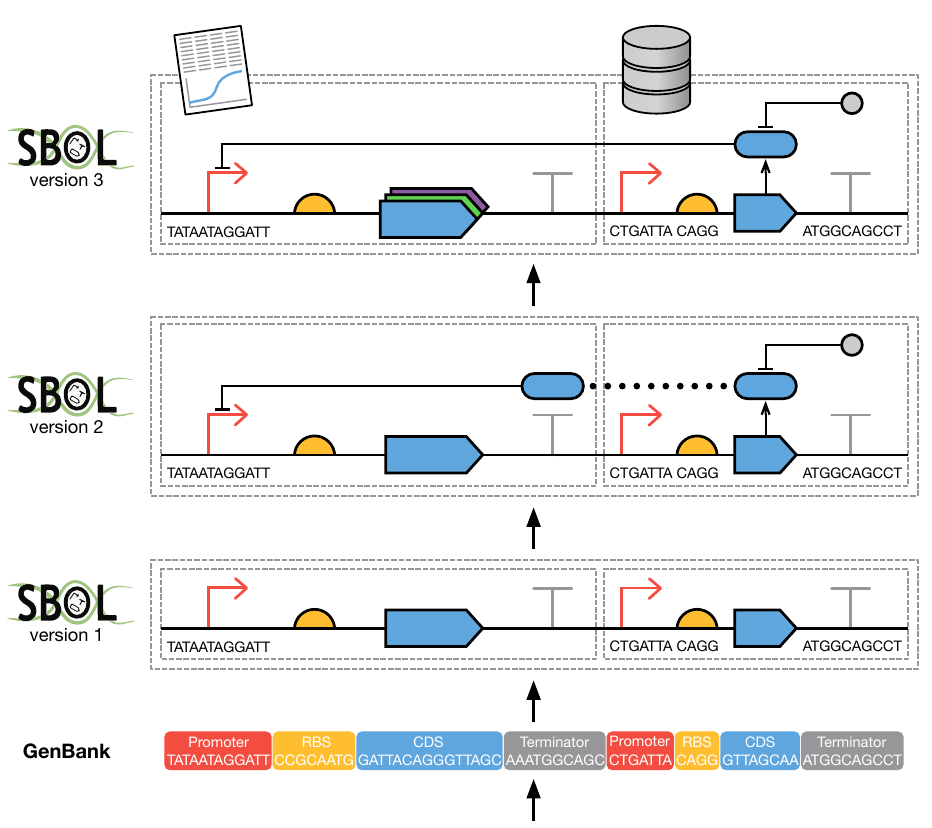
Figure 1: SBOL extends prior sequence description formats to represent both the structure and function of a genetic design in a modular, hierarchical manner, as well as its relationship to, and use within, experiments, plans, data, models,